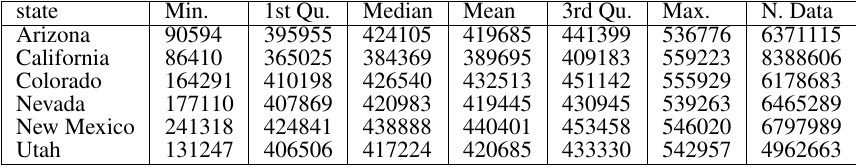
Table 1. Solar Direct Radiation in summer.